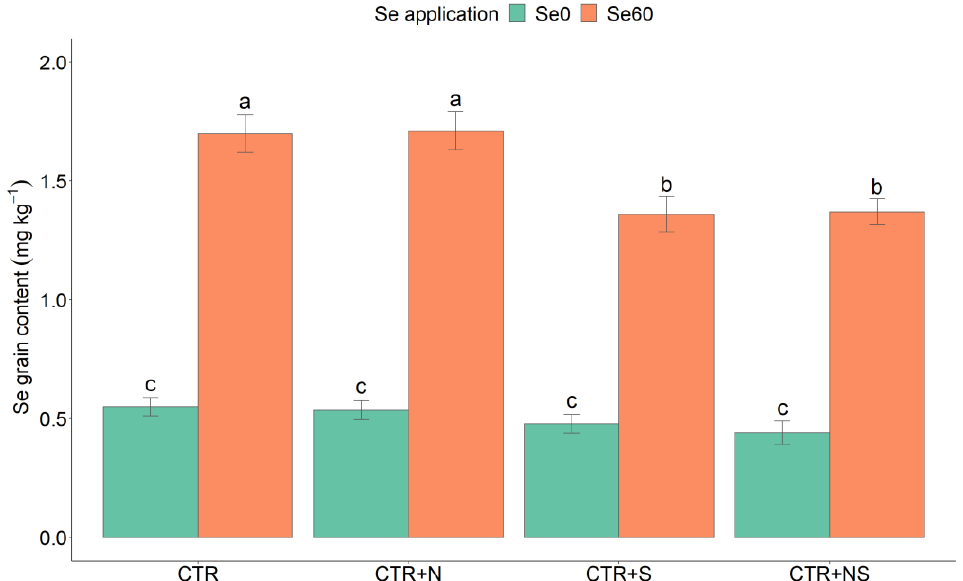
Figure 3. Effect of interaction organic fertilization × selenium application on Se content in grain. Se0, no selenium application; Se60, selenium application; CTR, control fertilized with dry blood meal at seeding; CTR + N, control plus N foliar application at the beginning of heading stage (BBCH stage 51); CTR + S, control plus S foliar application at flag leaf sheath opening stage (BBCH stage 47); CTR + NS, control plus the combination of S and N foliar applications at flag leaf sheath opening stage and at the beginning of heading (BBCH stage 47 and 51), respectively. Tukey HSD significant differences ( p < 0.05) are indicated by different letters. Vertical bars indicate standard errors (n = 24).